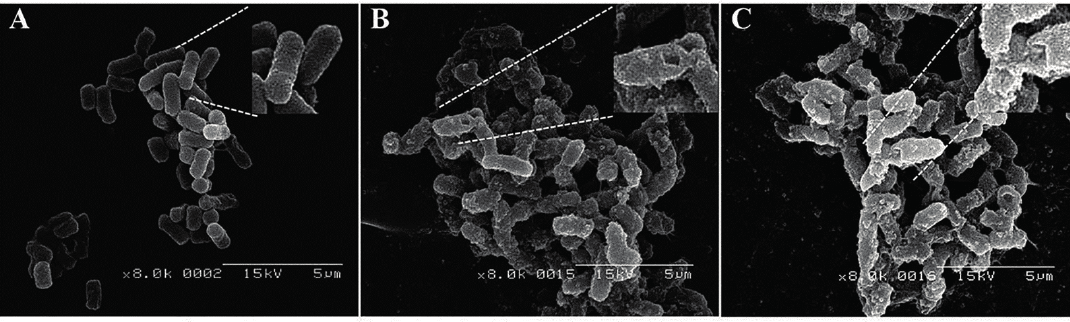
Figure 4. Morphological alteration of E. coli cells in the absence ( A ) or presence of β 5k ( B ) or β 10k ( C